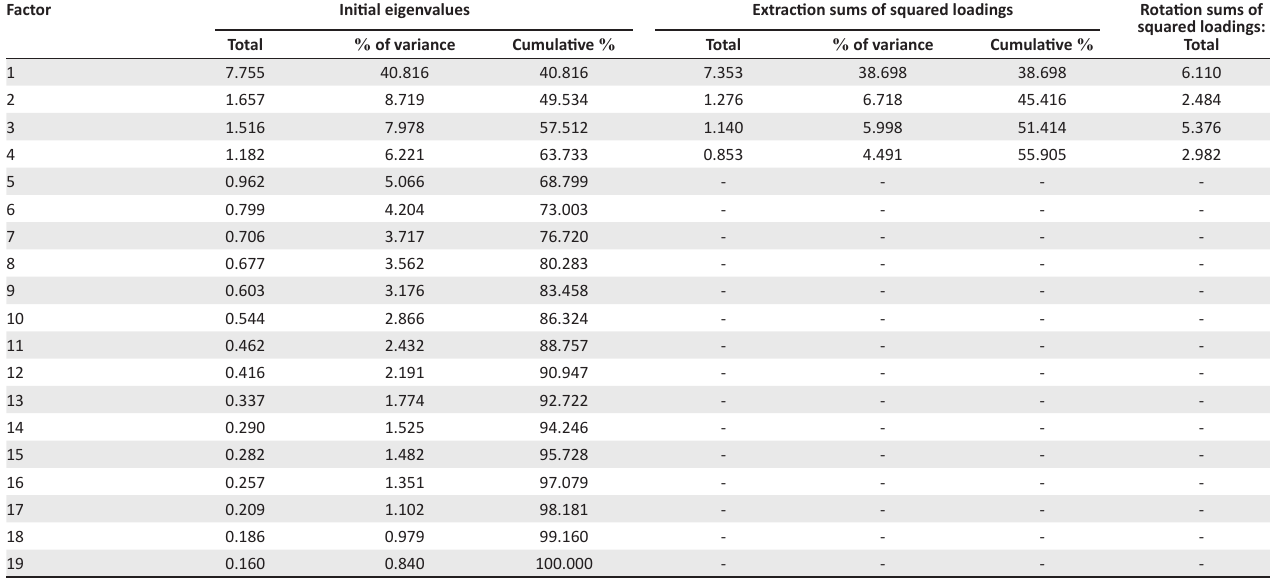
TABLE 1: Initial factor analysis – total variance explained.